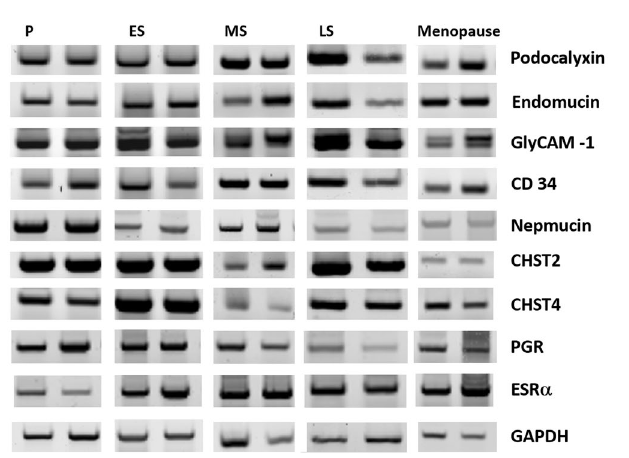
Figure 2. Gel electrophoresis of RT-PCR products during the four phases of the menstrual cycle. Cropped gels of RT-PCR products showed that the mRNA of the LSL peptide components podocalyxin, endomucin, GlyCAM-1, CD34, and nepmucin were differentially expressed in the four phases of the menstrual cycle and menopausal endometrium. Gene expressions of sulfotransferases (CHST2 and CHST4), ESR α and PGR were also found in the four phases of the menstrual cycle and menopausal endometrium. The mRNA levels were normalized to GAPDH mRNA levels. P: proliferative phase; ES: early-secretory phase; MS: mid-secretory phase; LS: late-secretory phase. (Examples of full-length gels are included in a supplementary Figure 2A and